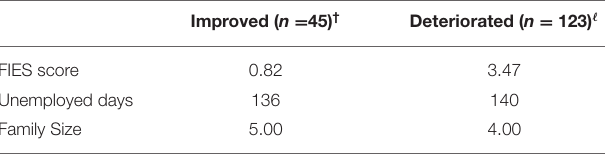
TABLE 2B | Improvement/deterioration in household food security (in terms of FIES score) due to impact of COVID-19 outbreak in March 2020 in Hyderabad,